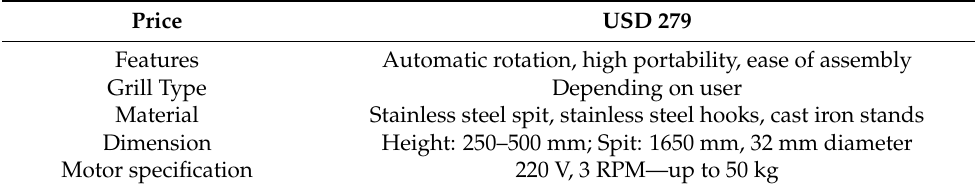
Table 2. Summary of the features and